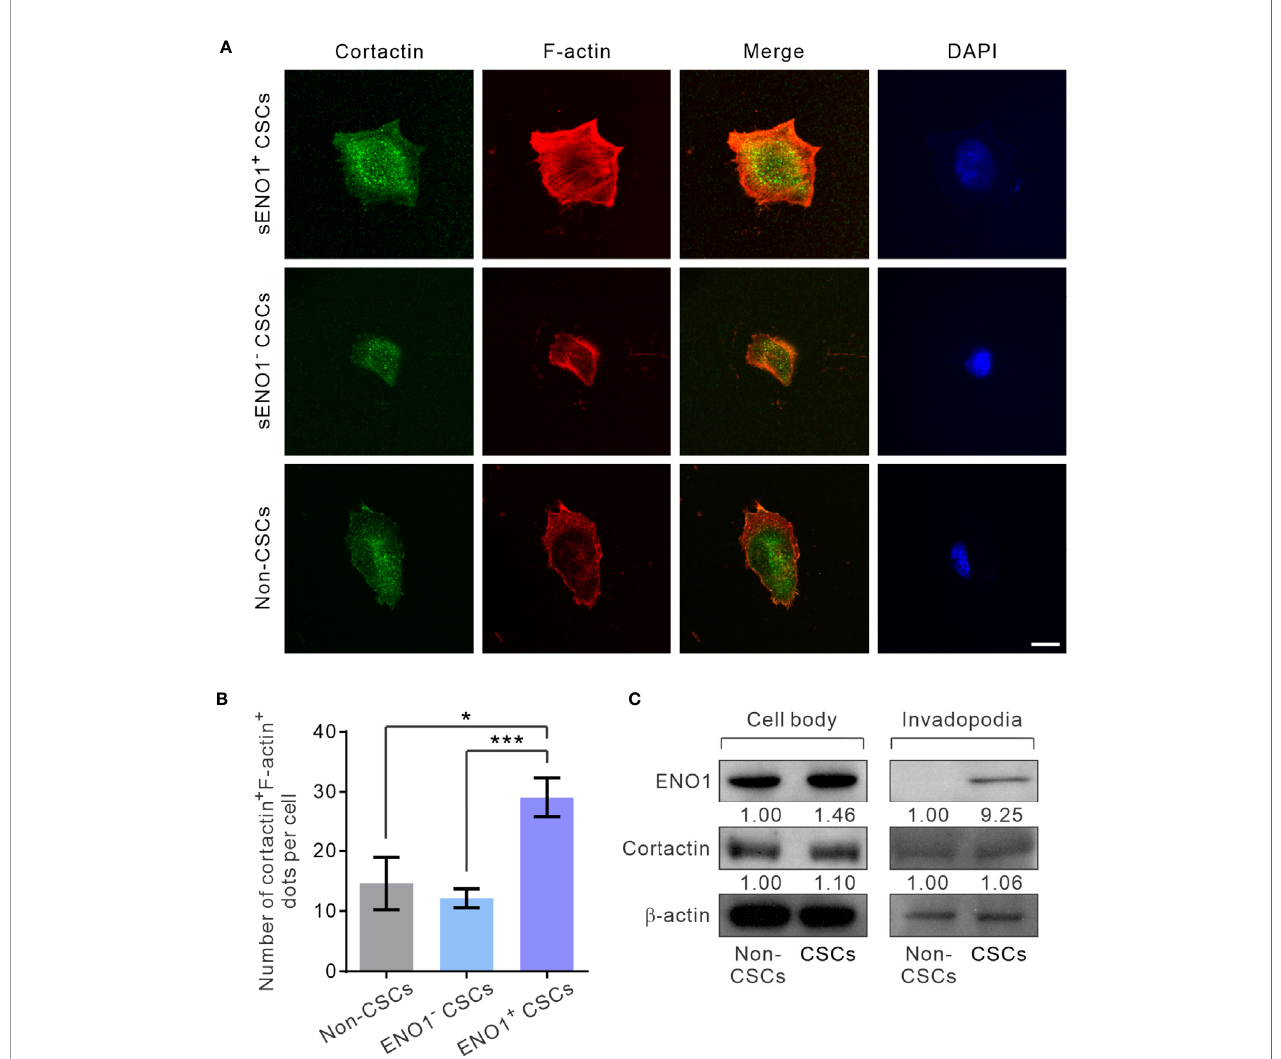
FIGURE 5 | sENO1 + CSCs generate more invadopodia than their sENO1 - counterparts. (A) Confocal views of sENO1 + PC-3 CSCs (represented by CD44 + CD133 + cells), sENO1 - CSCs, and non-CSCs (represented by cells in the other subpopulations) showing invadopodia (yellow puncta) with the colocalized cortactin (green) and F-actin (red) that penetrate the underlying gelatin matrix. Nuclei were counterstained with 4 ’ ,6-diamidino-2-phenylindole (DAPI; blue). Scale, 10 µm. (B) Quanti fi cation of the invadopodia density per cell in (A) . Error bars represent mean ± SEM from three independent experiments (n = 50 cells counted per sample). Unpaired t-test was performed where *p < 0.05, ***p < 0.001. (C) Representative immunoblots of ENO1, cortactin, and F-actin in the cell body (left) and the invadopodial (right) protein lysates fractionated from CD44 + CD133 + PC-3 CSCs seeded on gelatin for 6 hours. Protein levels were quanti fi ed by densitometric analysis of the bands, normalized to b -actin (loading